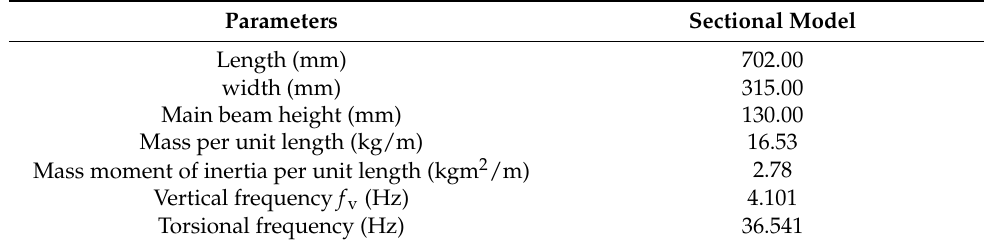
Table 1. Main parameters of sectional model.